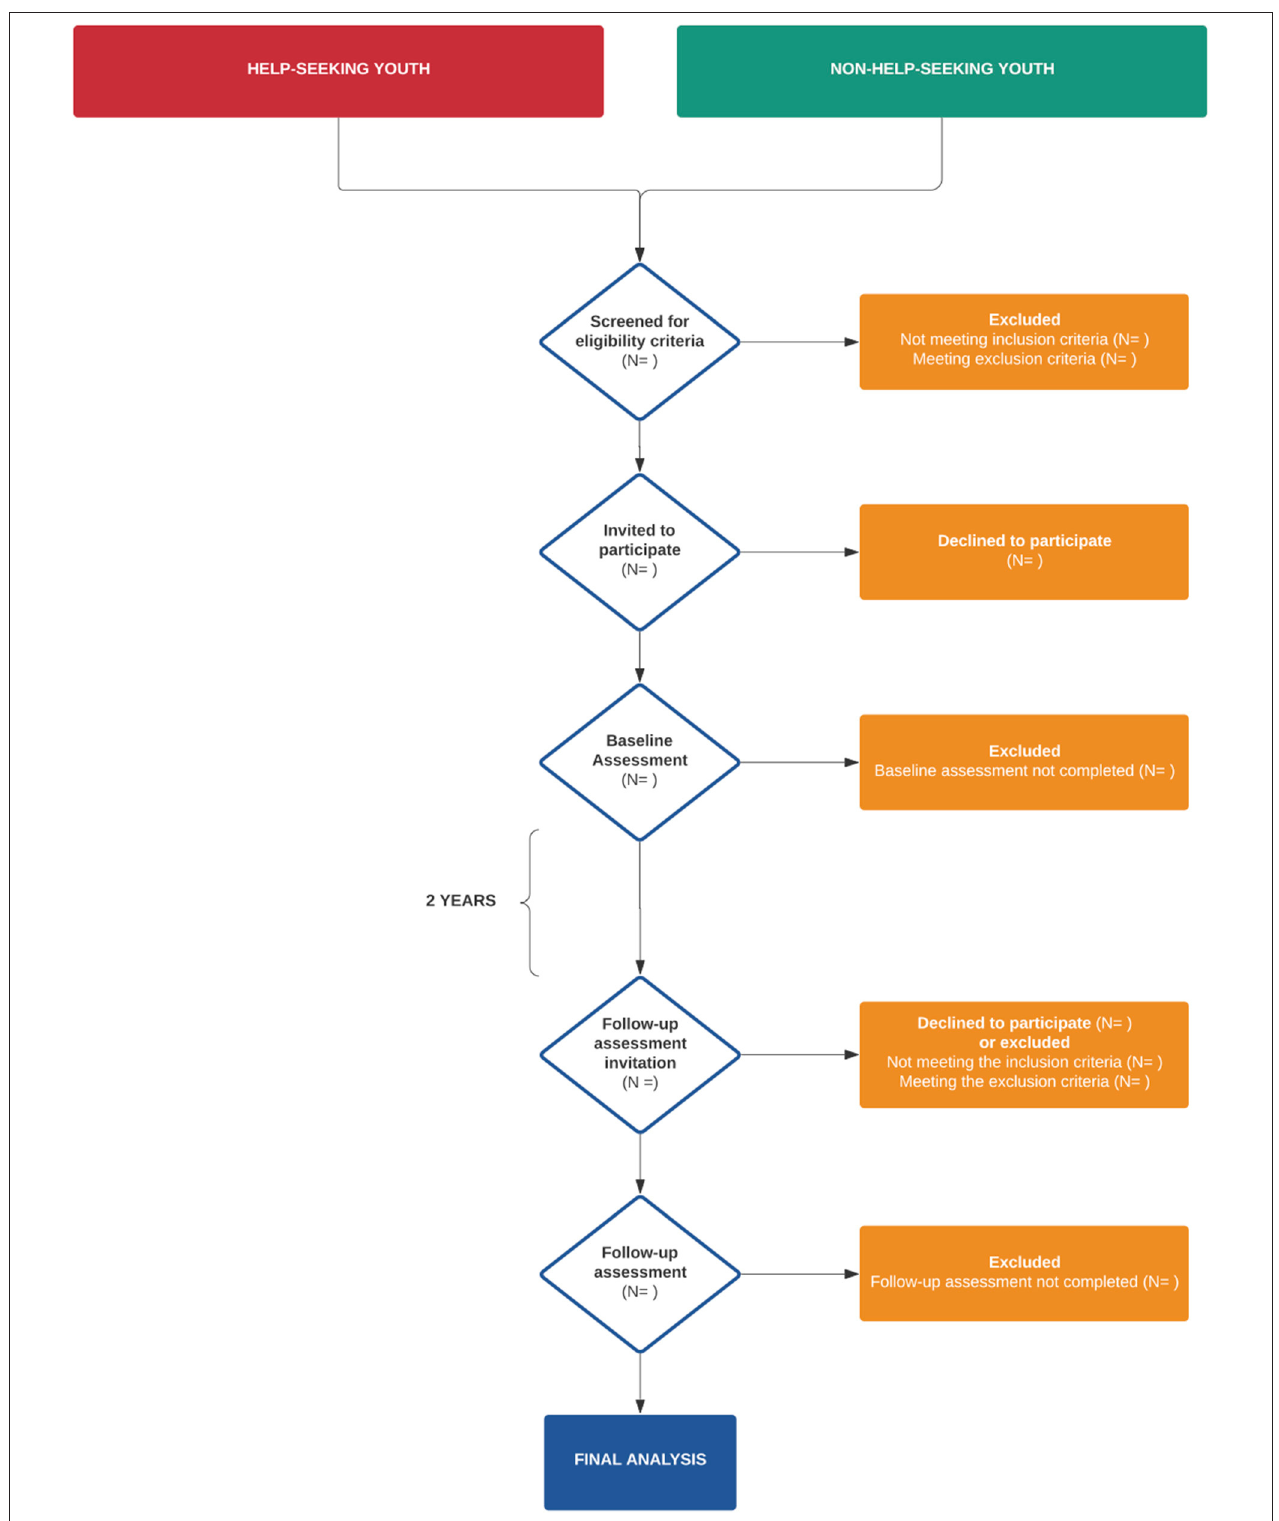
FIGURE 1 | Recruitment plan